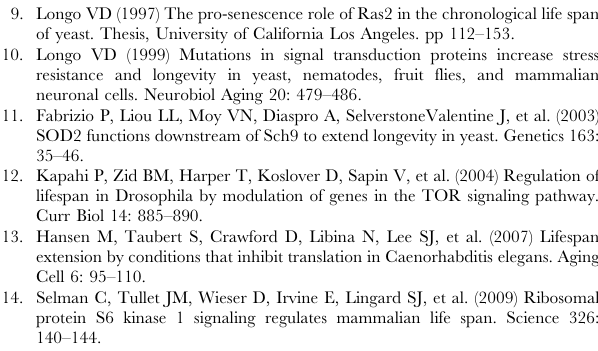
Table S1 CFUs values relative to the survival of the two YKO pools used for the genome-wide screen.